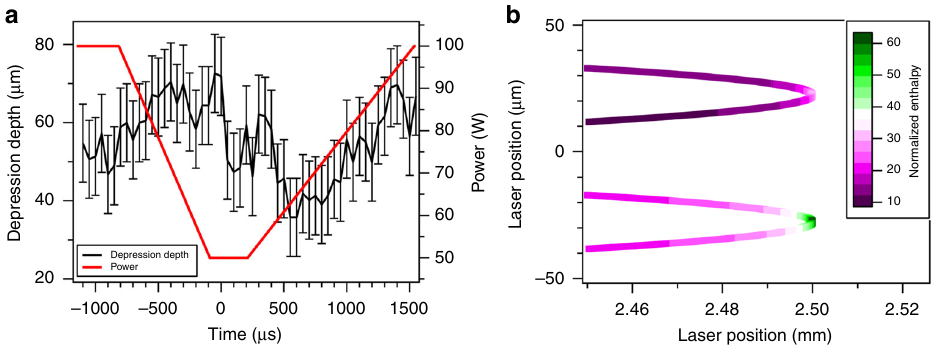
Fig. 6 Mitigation of vapor depression depth change during LPBF of Ti – 6Al – 4V. a The black line (left axis) corresponds to vapor depression depth as a function of time during a 100 W peak power pore mitigation scan strategy. Error bars represent uncertainty in the distance between the base of the vapor depression and the surface caused by surface roughness. Also shown is the commanded laser power as a function of time used in the scan strategy (red line). Depression depth values were measured for the case of a bare plate experiment because depression depth measurements in bare plate were less uncertain than the powder case, but the same trend is observed in both cases. b Normalized enthalpy ( Δ H h ) represented by the magenta-green color scale as s a function of laser position during the turn point for the full power and mitigated cases at 1000 mm s − 1 steady-state scan speed